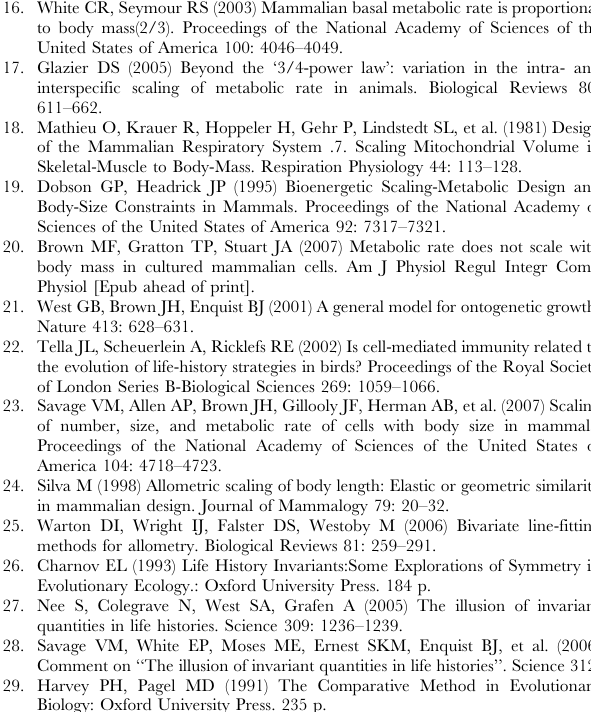
Table S1 The species, mass (kg), and time data collected from the literature. These data are from the literature listed in the supplementary material Text S1 and used in analyses across the five diseases; tD is the time to death from inoculation and tS is time to first symptom from inoculation (d). The five diseases are as follows: A= Anthrax, P =Pseudorabies Virus, R = Rabies, W= West Nile Virus, T = Transmissible Spongiform Encephalop- athy. Where multiple masses are listed, the value used with each disease is noted with the letter of the disease (A, P, R, W, or T). Found at: doi:10.1371/journal.pone.0001130.s001 (0.11 MB DOC) Text S1 Literature for disease data. Found at: doi:10.1371/journal.pone.0001130.s002 (0.05 MB